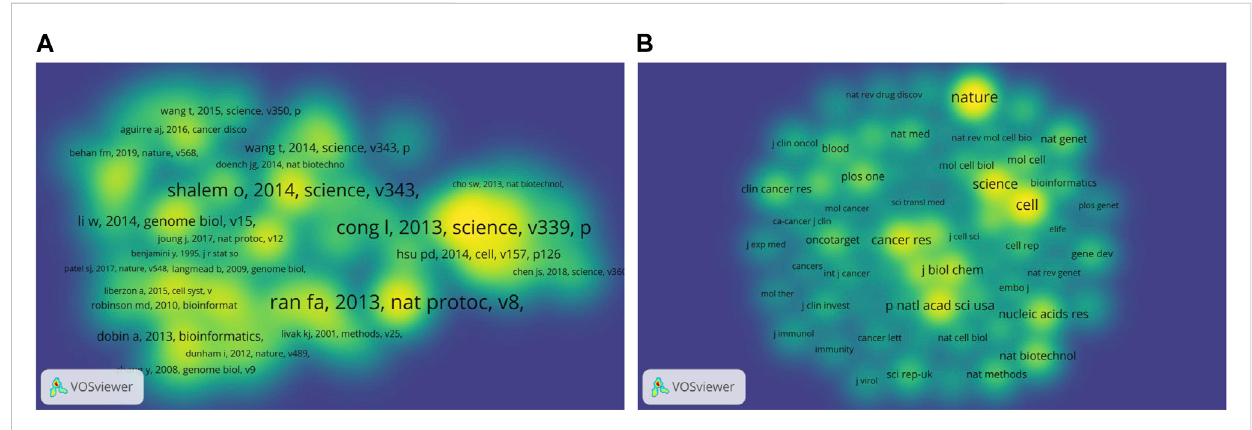
FIGURE 7 The bibliometric analysis of the co-citation on CRISPR in cancer. (A) Density visualization map of co-cited references. (B) Density visualization map of co-cited journals.